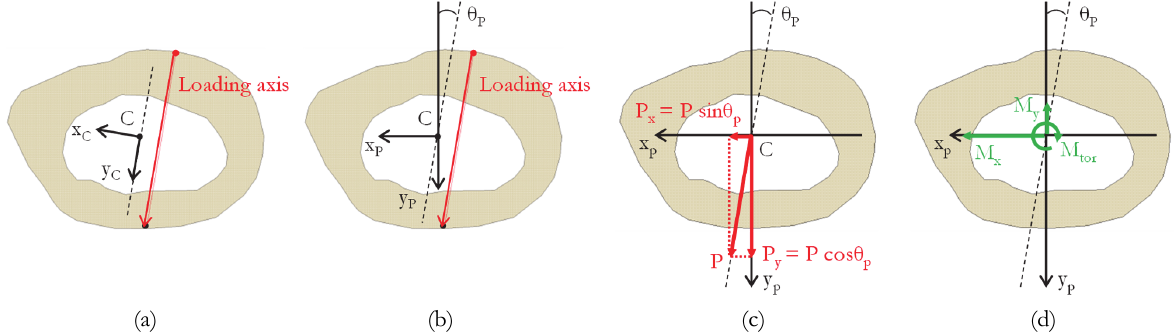
Figure 5: (a) The auxiliary centroidal system initially chosen arbitrarily (the loading axis is, also, shown); (b) The principal centroidal system determined; (c) The components of the applied load (analyzed along the principal centroidal axes); (d) The bending and the torsional moments developed.